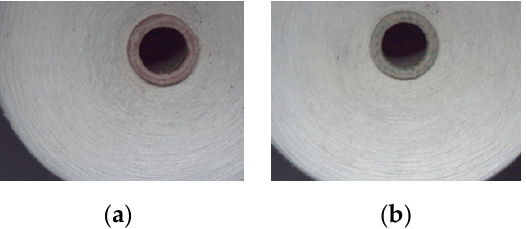
Figure 18. Unidentified cone yarn types: ( a ) cone yarn with the rose red bobbin; ( b ) cone yarn with